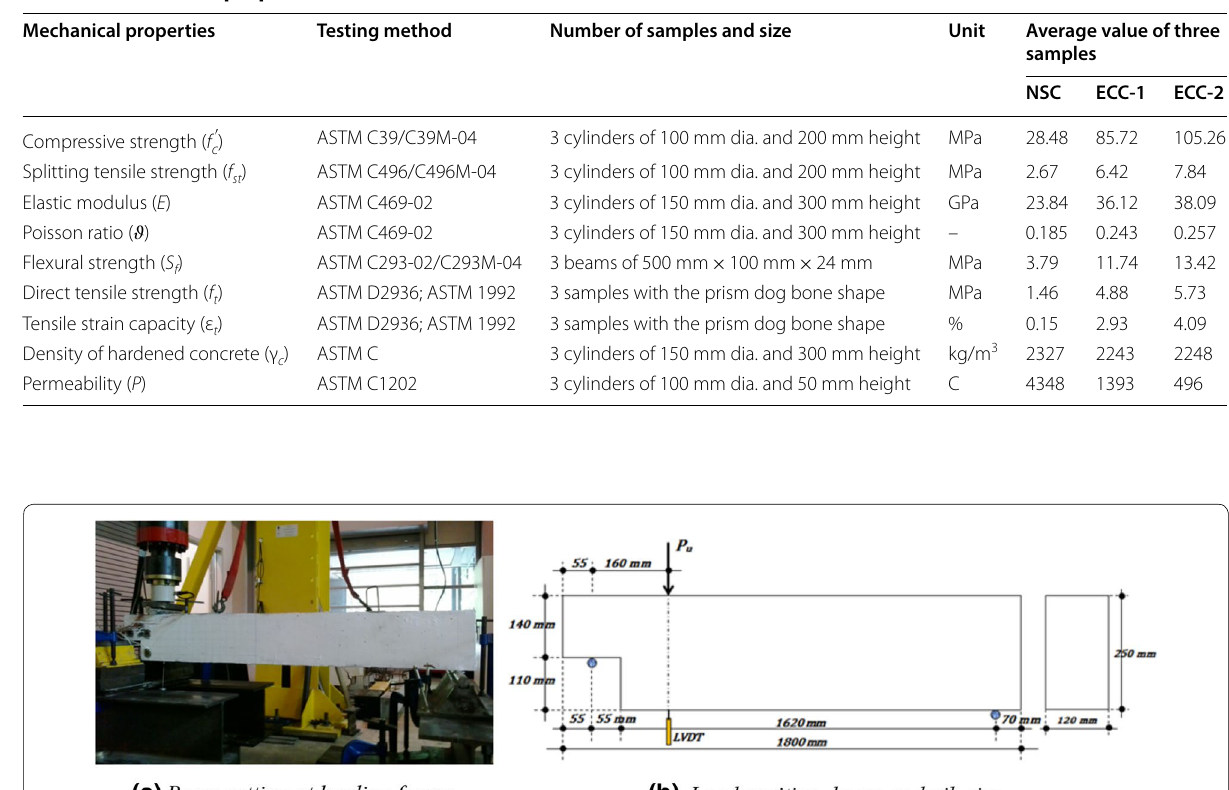
Table 4 Mechanical properties of the hardened concrete/ECC.